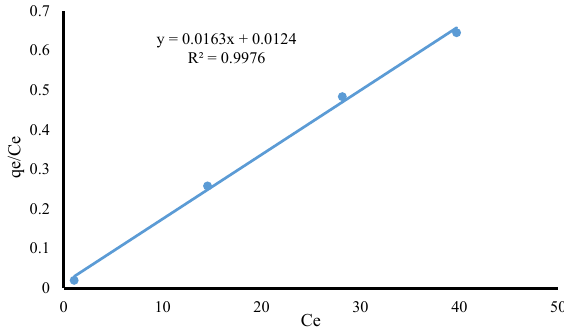
Fig. 8: Langmuir isotherm model for removing nickel from electroplating industry wastewater using bamboo activated carbon